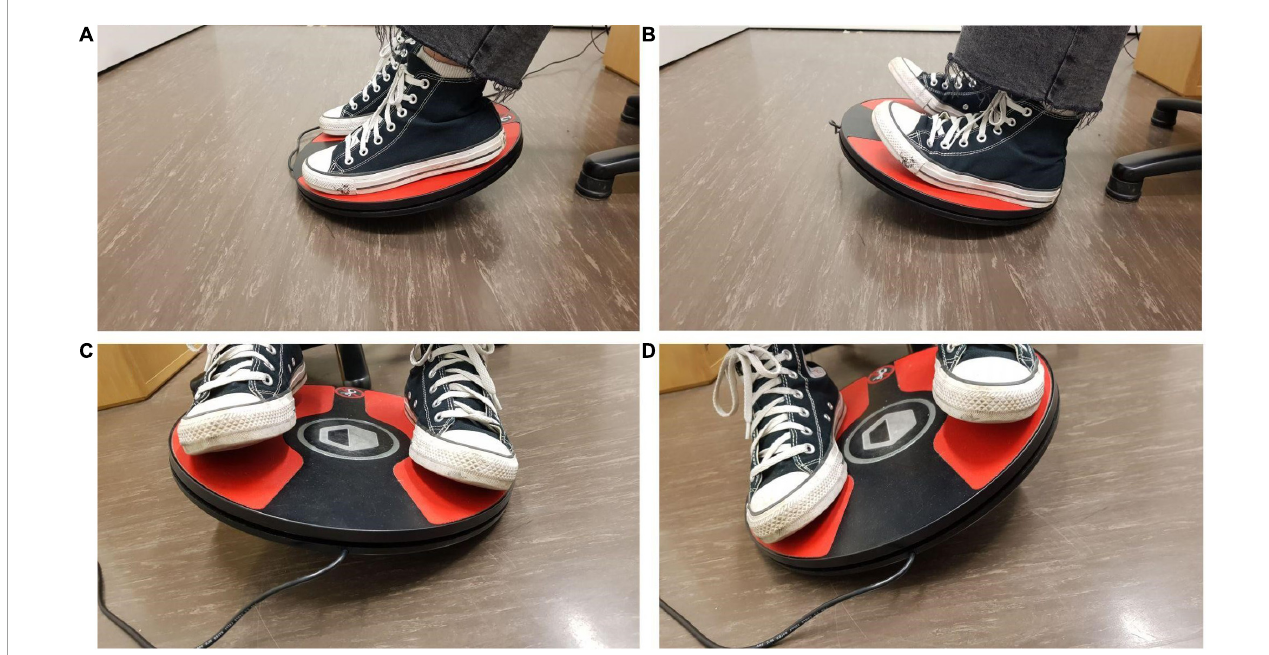
FIGURE5 The participant is titling the foot controller with their feet to (A) move forward and (B) backward through the virtual environment, respectively. The participant is titling the foot controller with their feet to (C) the left and (D) to the right to turn their heading direction in the urban virtual environment toward the left and right,